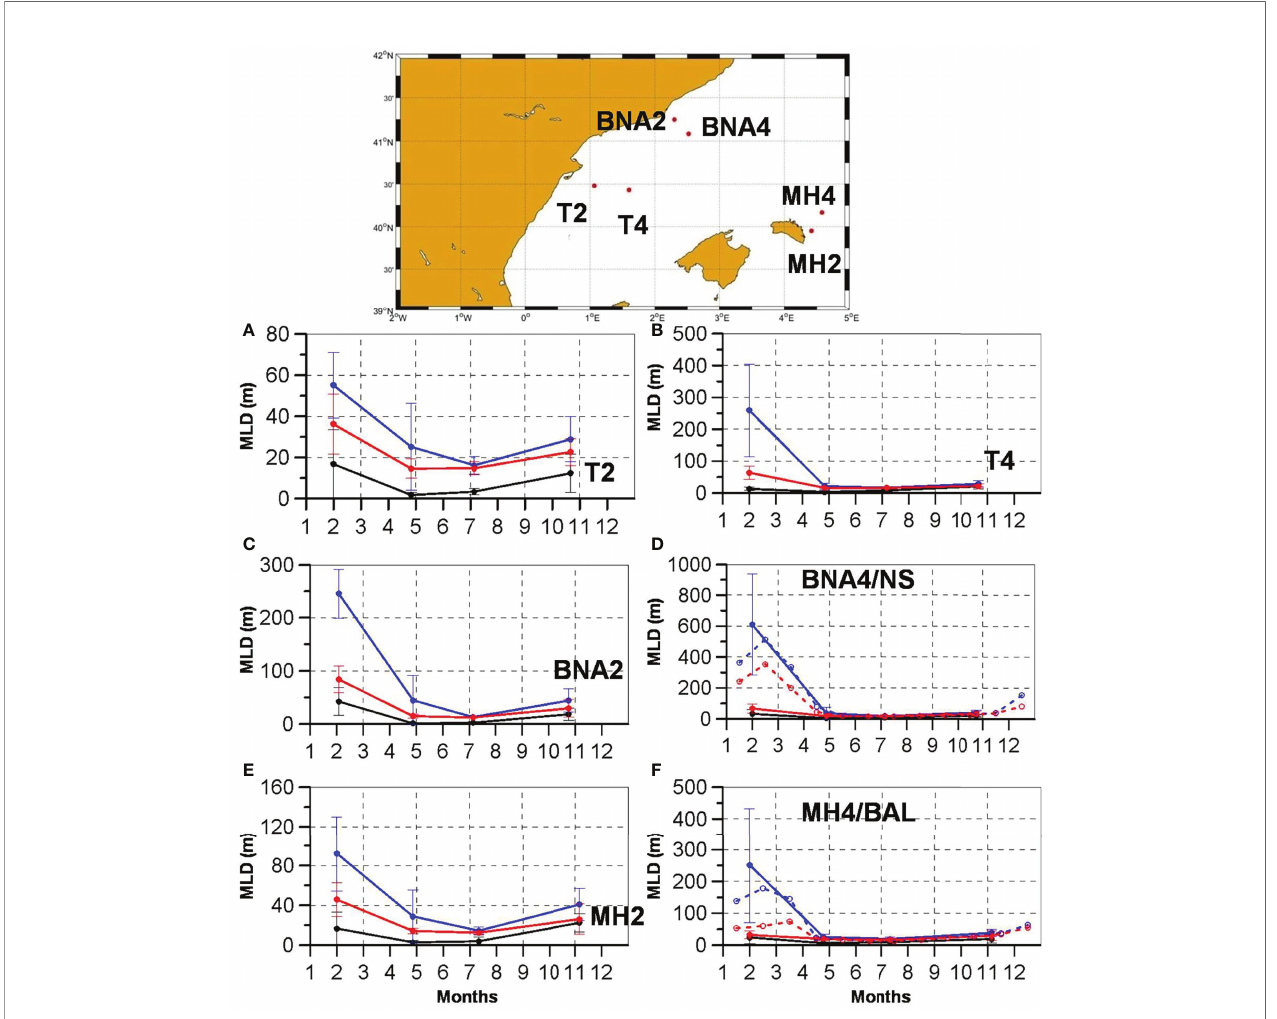
FIGURE 6 | Seasonal cycles of the MLD estimated from the three-monthly sampling of RADMED projects (continuous lines) at some selected oceanographic stations (see labels inserted in these fi gures and the map for the locations), and form the Argo MLD at the regions of the Northern Sector (D) and the Balearic Islands (F) (dashed lines). Blue lines correspond to the t-threshold method, red lines to the d-threshold method, and black lines to the temperature extreme curvature method. Please, note the different ranges of the y-axis between